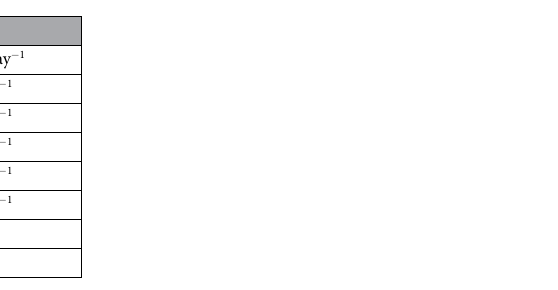
Table 3. Average value of the main parameters of the pretreated dairy wastewater (SBR